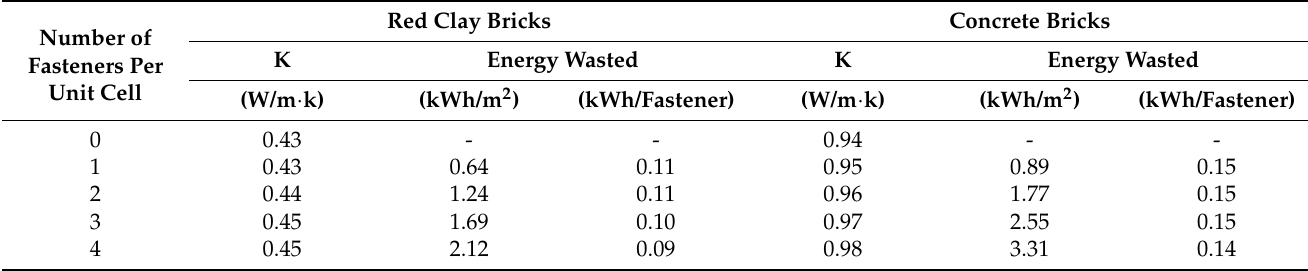
Table 5. Thermal conductivities and energy wasted at different numbers of